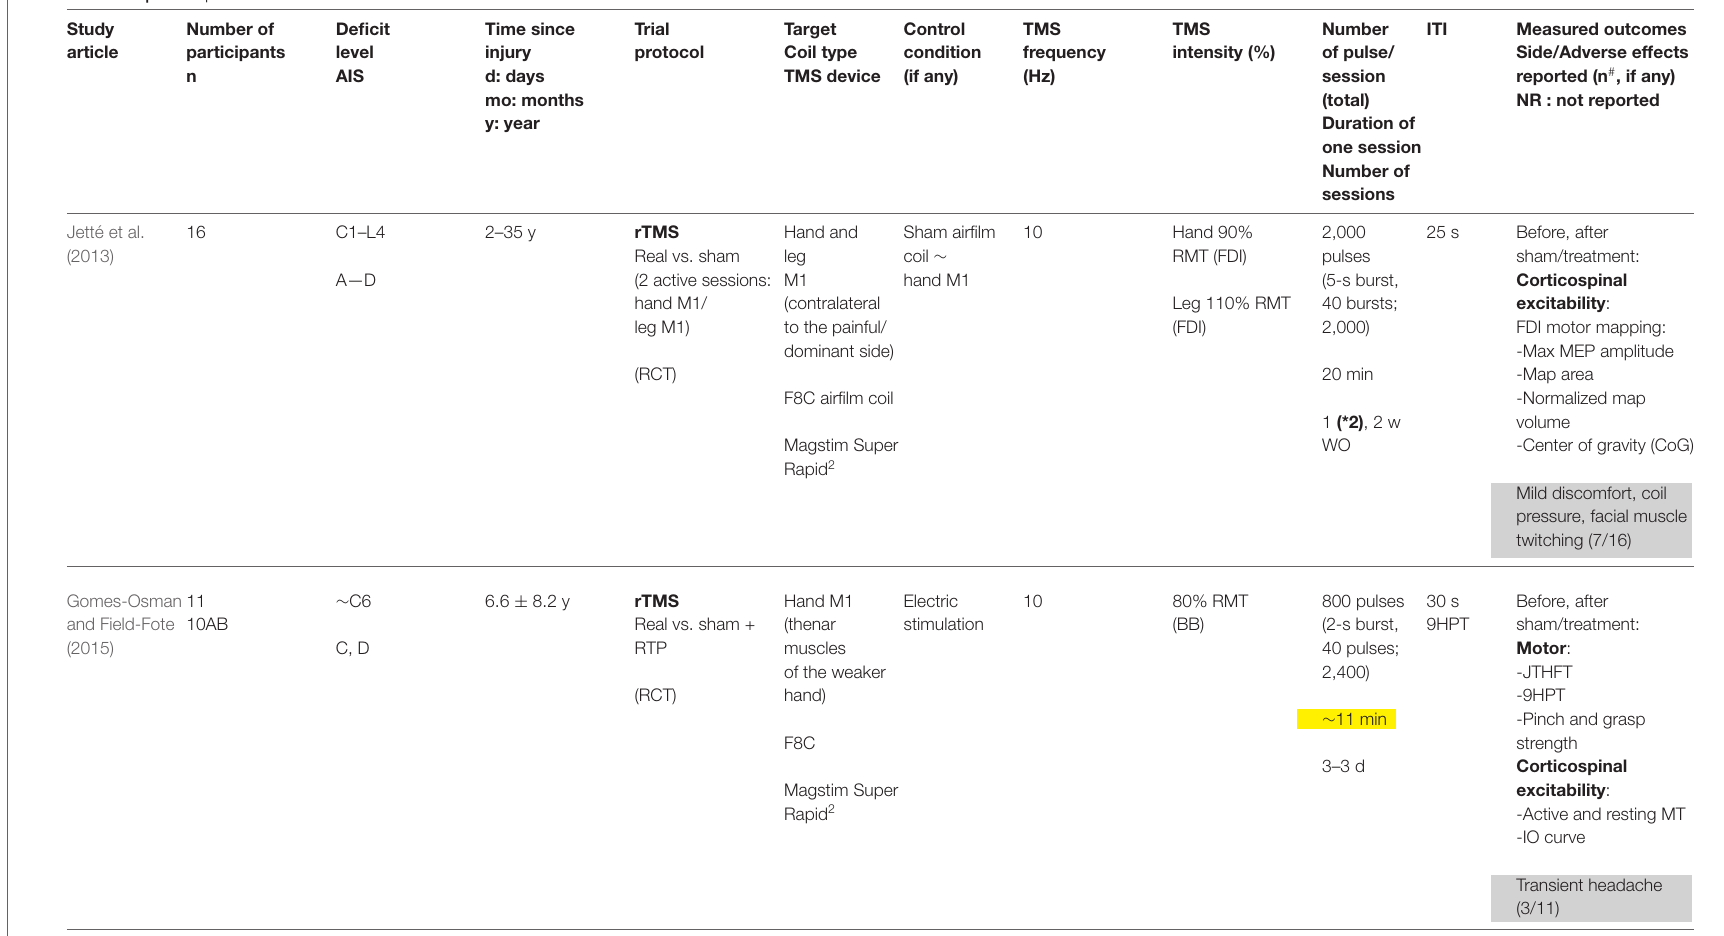
TABLE 1 | Descriptive table of the reviewed rTMS